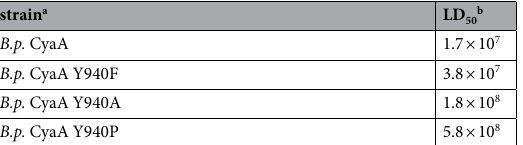
Table 1. The aromatic ring at position 940 is required for the biological activity of CyaA secreted by B. pertussis during in vivo respiratory infection of Balb/cByJ mice. a B. pertussis strains were grown in SSM as described in Methods. b Balb/cByJ mice were intranasally infected with individual B. pertussis strains to determine LD 50 values (CFU/mouse) as described in detail in